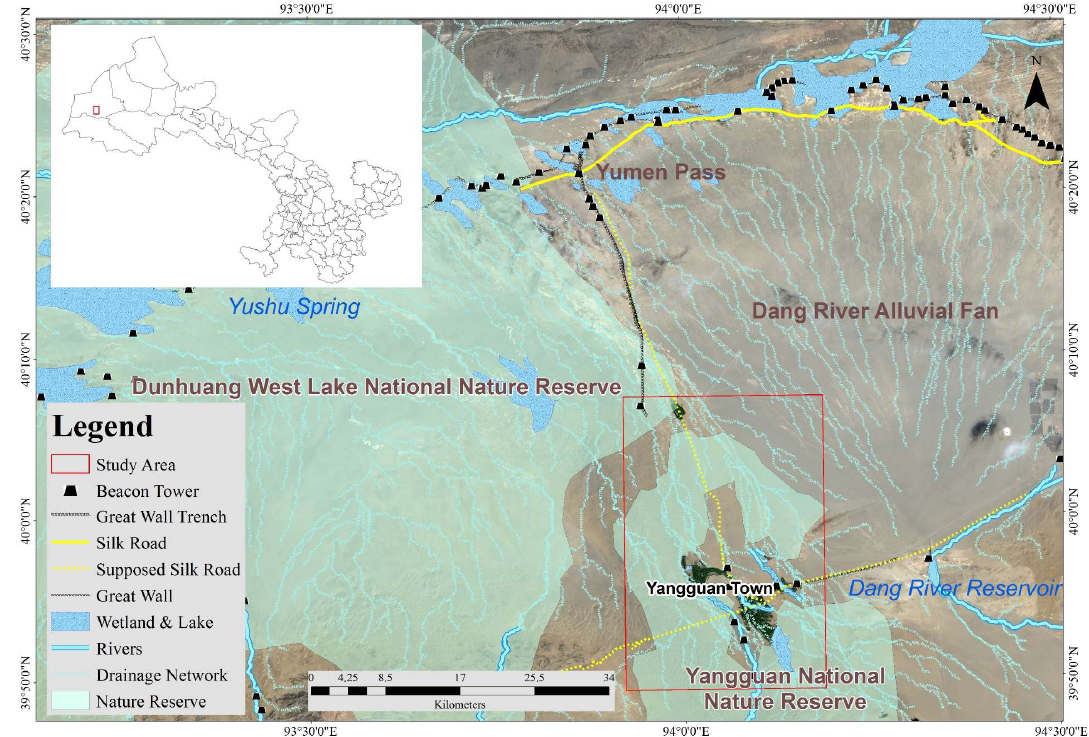
Figure 1. Location of the Nanhu oasis study area is outlined by the red rectangle. The study area is located in the town of Yangguan in the Gansu Province in China (the rectangular box in the upper left part), stretches west to the Dang River alluvial fan, and is surrounded by the Yangguan National Nature Reserve and the Dunhuang West Lake National Nature Reserve, with the famous heritage sites of the Ancient Silk Road and the Han Dynasty beacon towers.